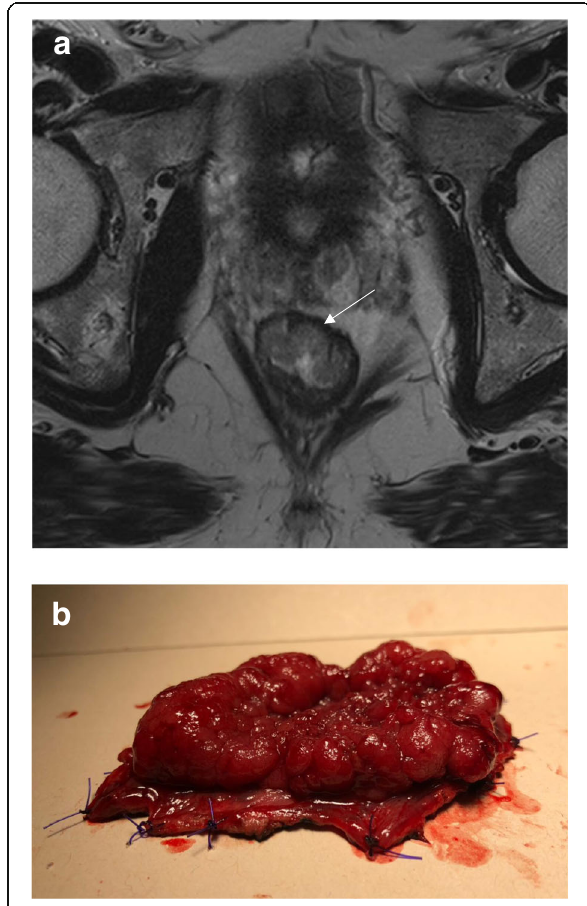
Fig. 6 Early rectal cancer staging. a High-resolution axial T2WI shows a semiannular low lying lesion extending from 10 to 3 o ’ clock confined to the rectal wall with no signs of invasion of the muscularis propria (arrow). The lesion was staged as mrT1N0, and local excision was performed. b Surgical specimen. The resected specimen after local excision. Histopathological analysis diagnosed adenoma